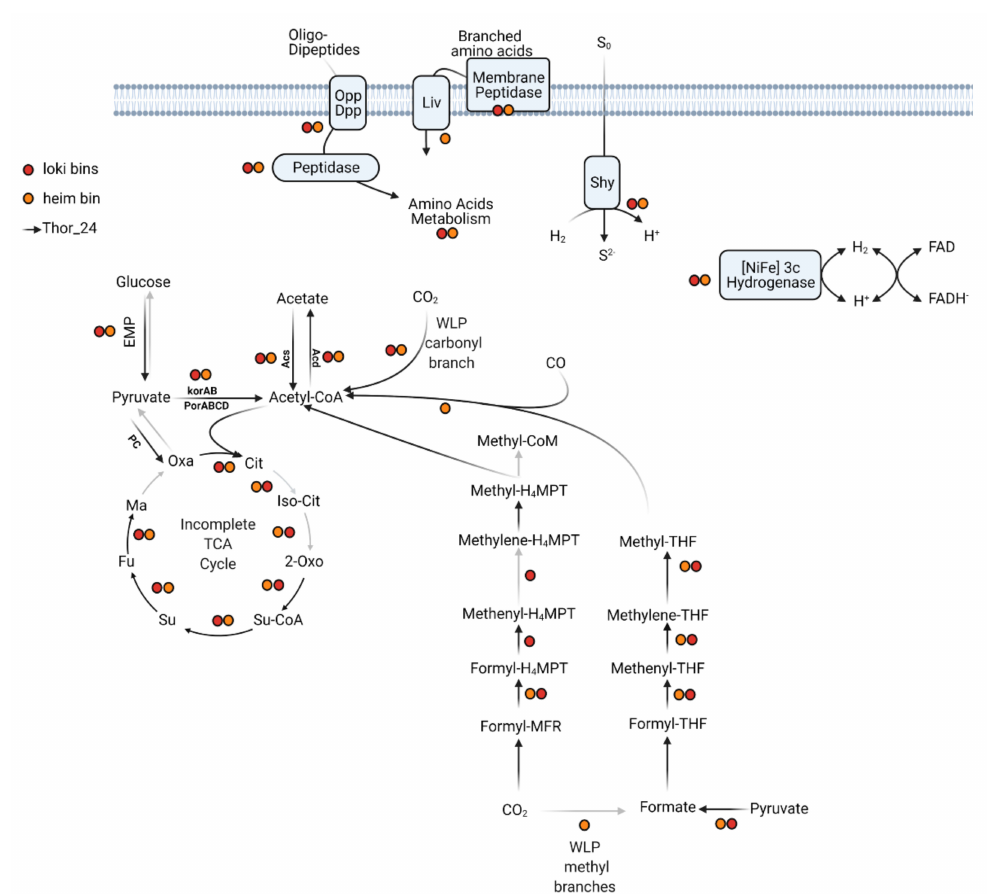
Figure 2. Central metabolism of Thorarchaeota MAG (Thor_24) and Loki- (Loki) and Heimdall- (Heim) archaeota low- quality bins. Gray arrows indicate pathways/reactions missing in Thor_24. Colored dots indicate the presence of enzymes in low-quality bins (red for Loki and orange for Heim). The annotation files for each pathway are reported in Tables S2 and